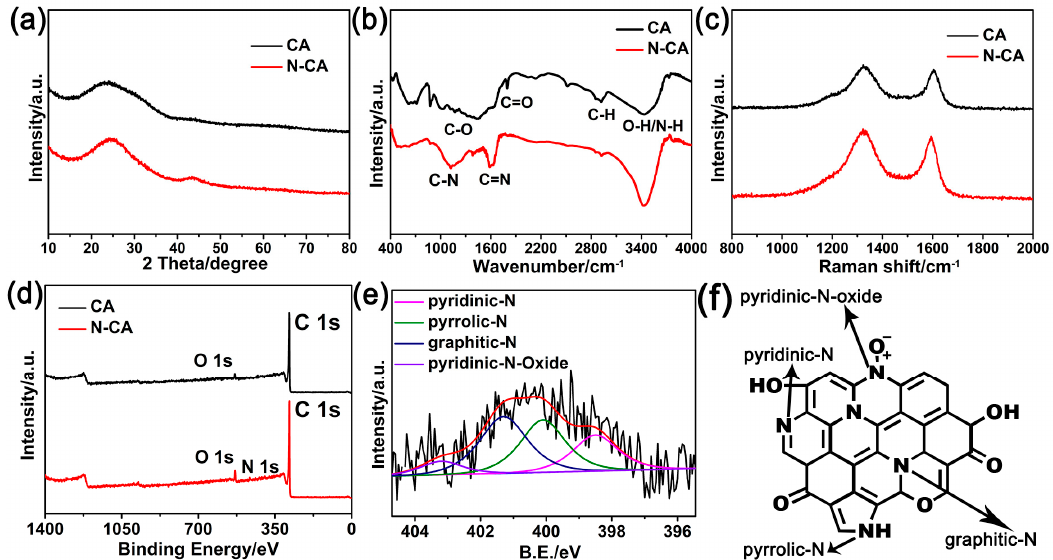
Figure 2. ( a ) XRD patterns, ( b ) IR, and ( c ) Raman spectrum of the CA and the N-CA; ( d ) XPS survey spectra of the CA and the N-CA; ( e ) N 1s high-resolution XPS spectra of the N-CA; and ( f ) schematic model of nitrogen- and oxygen-containing surface functional groups on carbon.